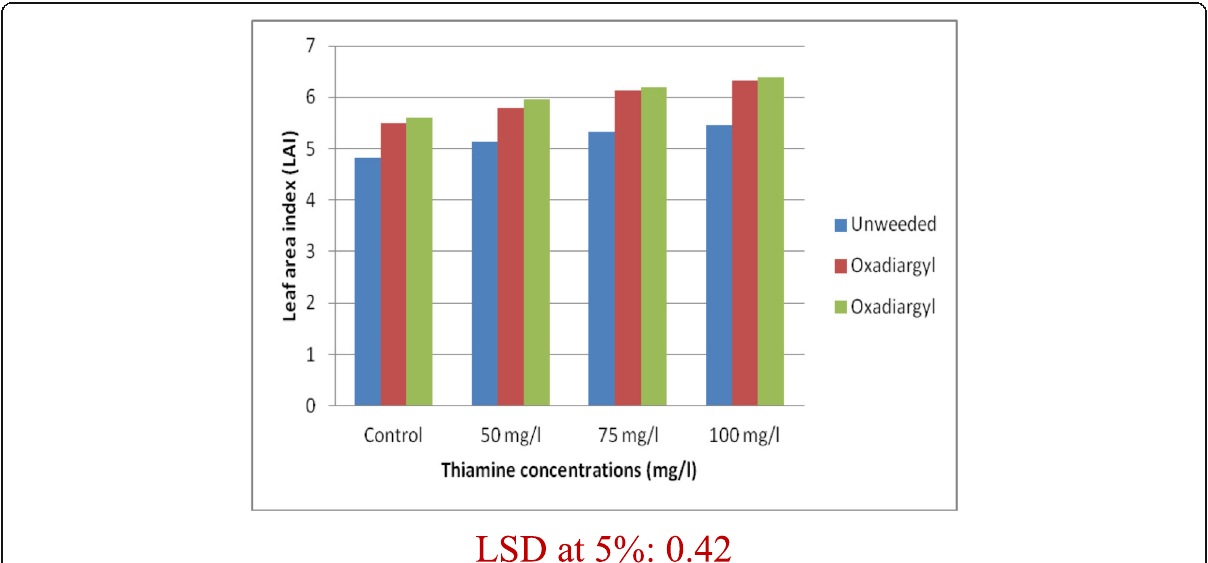
Fig. 5 Effect of the interaction between thiamine levels and weed control on LAI of faba bean at 90 days from sowing (combined analysis of two seasons)